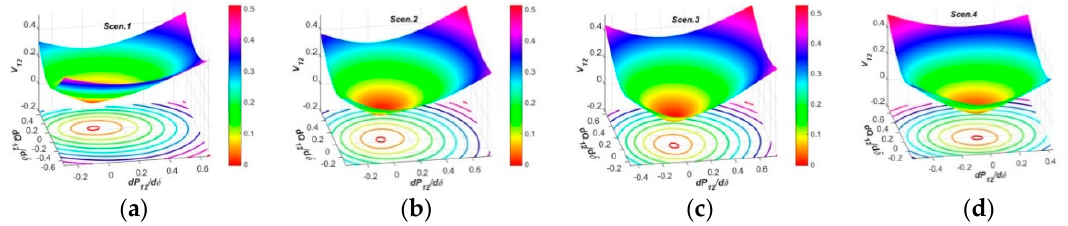
Figure 6. Spatial surfaces of PFG to CIV3 at SCP2 in spaces: ( a – d ) Spatial surfaces of PFG to CIV3 in four regulation scenarios.